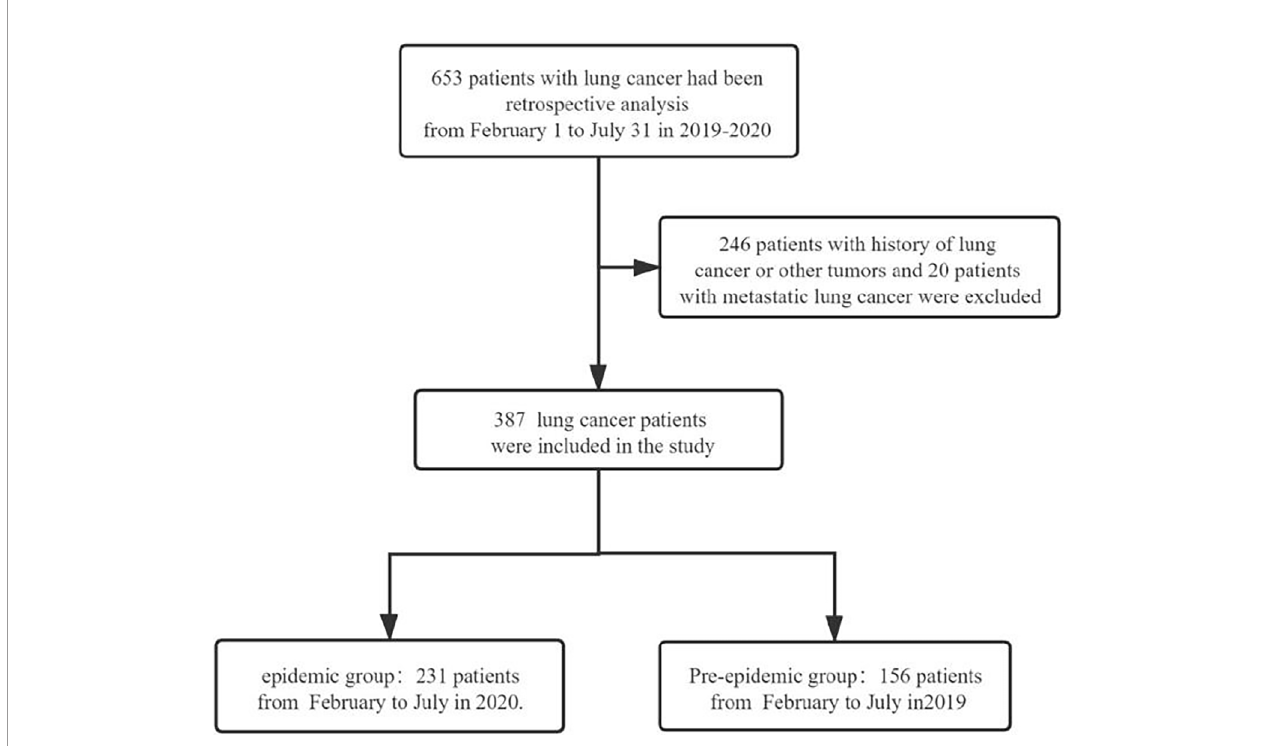
FIGURE 1 | Flow chart for patient inclusion in the